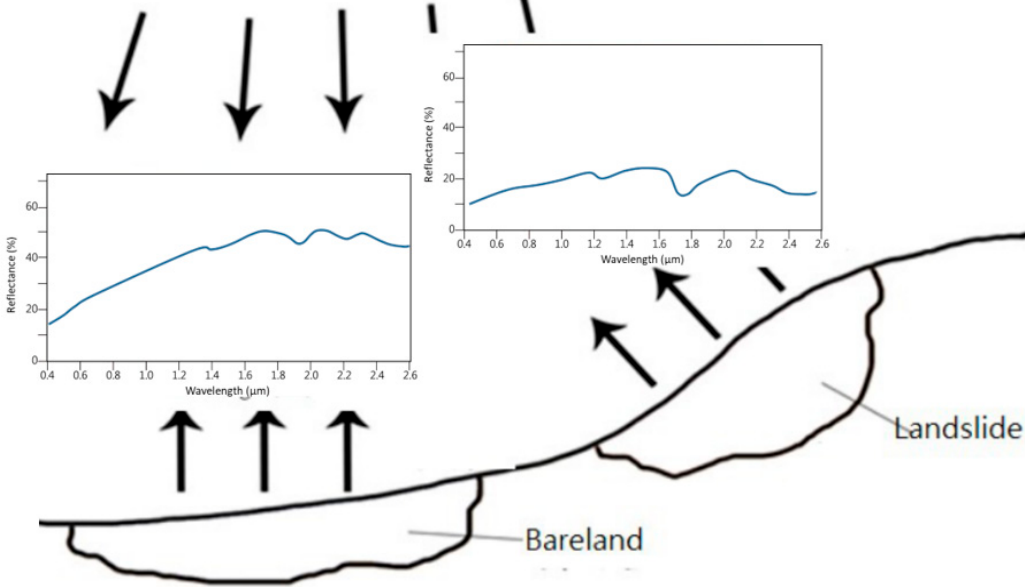
Figure 1. Theory for different reflection of target category (bareland vs. landslide).